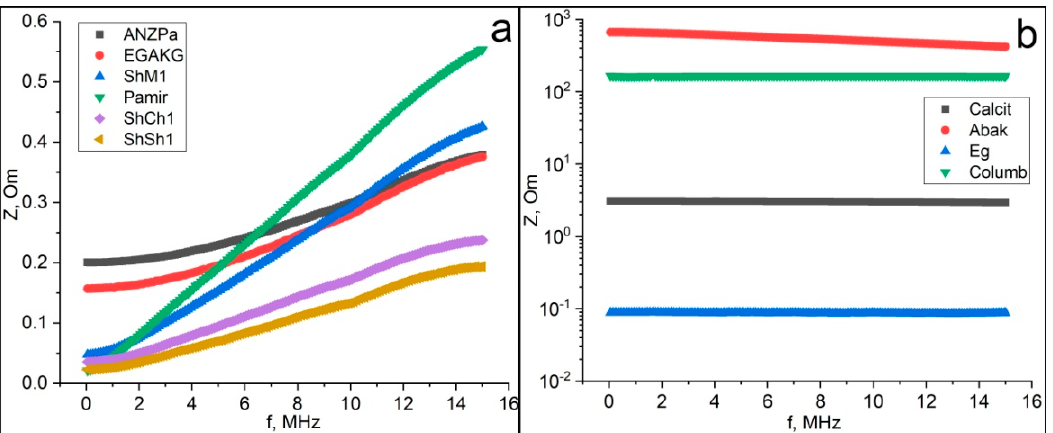
Figure 12. The dependence of the impedance on the frequency ( a —samples with an increase in impedance. b —samples with a constant or decreasing impedance). Samples code: Pamir—graphite; ShCh1, ShSh1, ShSh2, ShM1—samples of shungite carbon from various occurrences of Karelia; anthraxolites from Kazakhstan (Abak), Novaya Zemlya islands (ANZPa, Calcit, Eg), Colombia (Columb), and Subpolar Ural, Kozhim river (EGAKG).